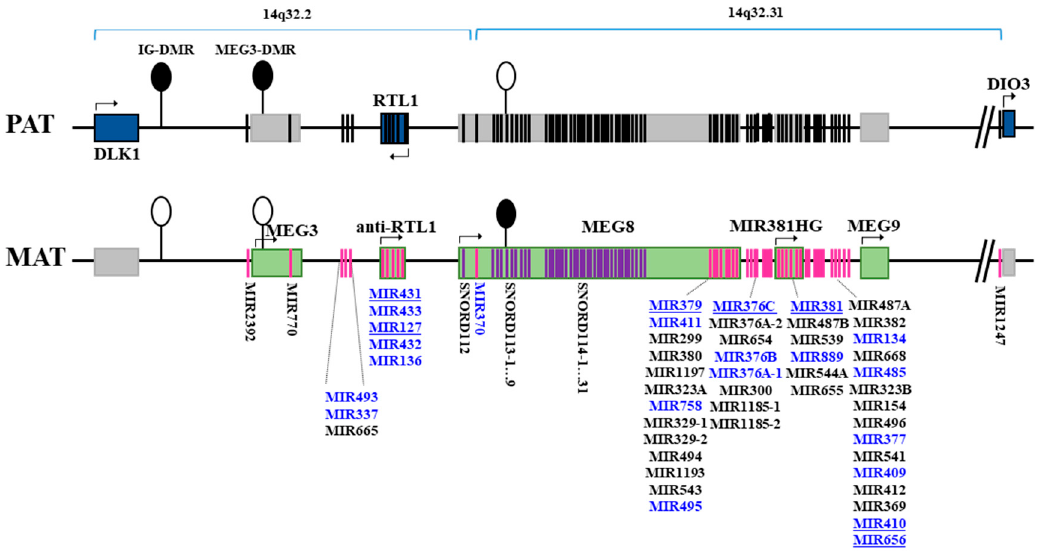
Figure 1. Localization of miRNA genes with increased expression in male patients with relapsing-remitting multiple sclerosis (in blue color) within DLK1-DIO3 imprinted locus on human chromosome 14q32. The schematic representation of the locus was constructed based on current concept of its structure (according to Human Genome Assembly GRCh38.p12 [22]). Groups of miRNA genes located in close proximity to each other or referred to one structural unit of genome are pooled in lists. Altogether, this locus harbors two large clusters of miRNA genes (10 miRNA genes in 14q32.2 and 44 miRNA genes in 14q32.31). Underlined miRNAs were further taken for validation analysis. The DLK1-DIO3 imprinted locus contains three paternally-expressed protein-coding genes: DLK1 (Delta-like homolog 1), which is located at the 5 (cid:48) -end and encodes for a protein involved in the Notch signaling pathway [23], DIO3 (type III iodothyronine deiodinase) located at the 3 (cid:48) -end and involved in controlling thyroid hormone homeostasis [24] and RTL1 (Retrotransposon Gag Like 1). Fully complementary antisense transcript anti- RTL1 is expressed from the maternal chromosome and acts as a repressor for RTL1 . The locus also contains long non-coding RNAs genes ( MEG3 , MEG8 , MIR381HG , MEG9 ), coming from the maternal chromosome. MEG8 harbors a tandemly repeated array of the C/D-box snoRNA family, namely SNORD112 , SNORD113 , SNORD114 , consisting of one, nine and 31 paralogous copies, respectively. The expression of genes is regulated via imprinting control regions which harbor differentially methylated regions (DMRs): the intergenic DMR (IG-DMR), MEG3-DMR and MEG8-DMR. The IG- and MEG3-DMRs are methylated on the paternal and unmethylated on the maternal allele, while the MEG8-DMR is oppositely methylated on the maternal allele [25]. PAT and MAT stand for paternal and maternal chromosomes; DMR—differentially methylated region. Filled ellipses represent methylated DMRs, and unfilled represent unmethylated DMRs. Blue rectangles represent protein-coding paternally-expressed genes, and green—maternally-expressed non-coding genes; gray rectangles represent repressed genes. Black strips indicate for paternal repressed miRNA and SNORD genes; pink and violet strips indicate maternally-expressed miRNA and SNORD genes, respectively.